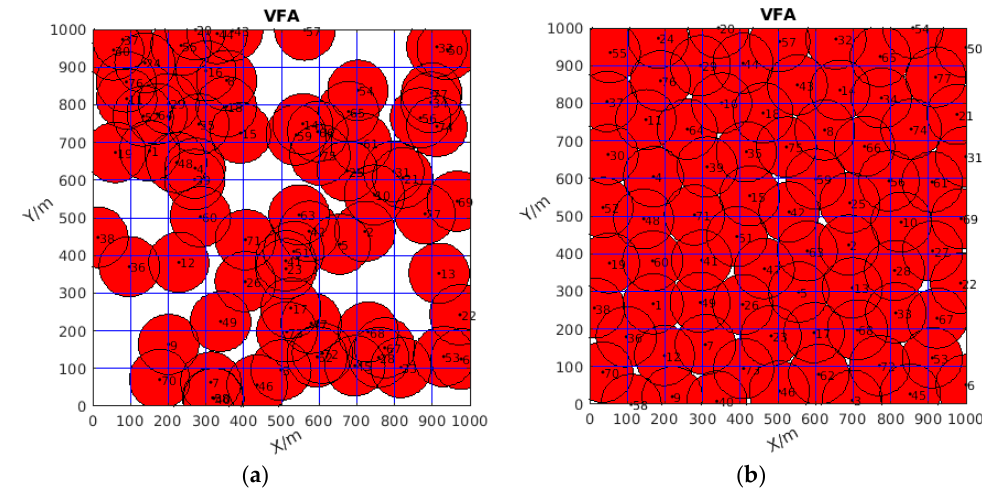
Figure 7. ( a ) The initial diagram of wireless sensor network coverage (distributed randomly); ( b ) the coverage optimized by